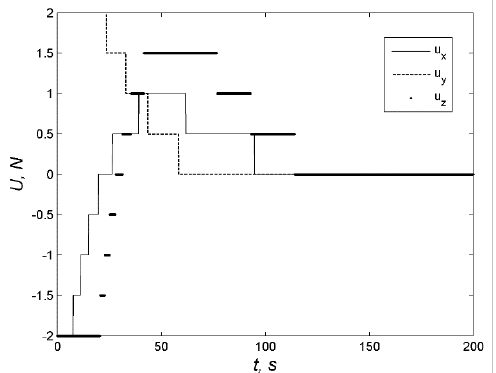
Figure 7. Thrust vector of satellite.